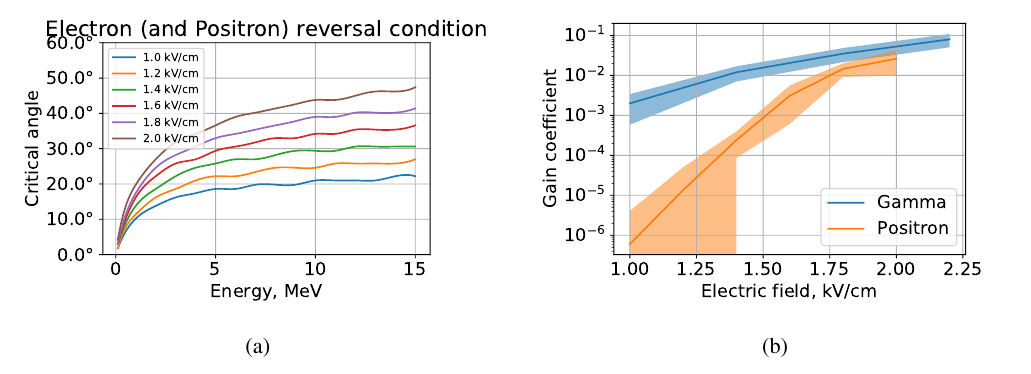
Figure 3: a) Minimum reversal angle between electron motion direction in moment of its birth and electric field depending on electron energy. b) Positron (gamma) feedback coe ffi cient in dependence on cell electric field for next parameters: primary electron energy — 3 MeV , field area size — 400 meter , electric field from 1 to 2 kV / cm , air density — 0 . 5 k g/ m 3 ( ∼ 0 . 5 atm